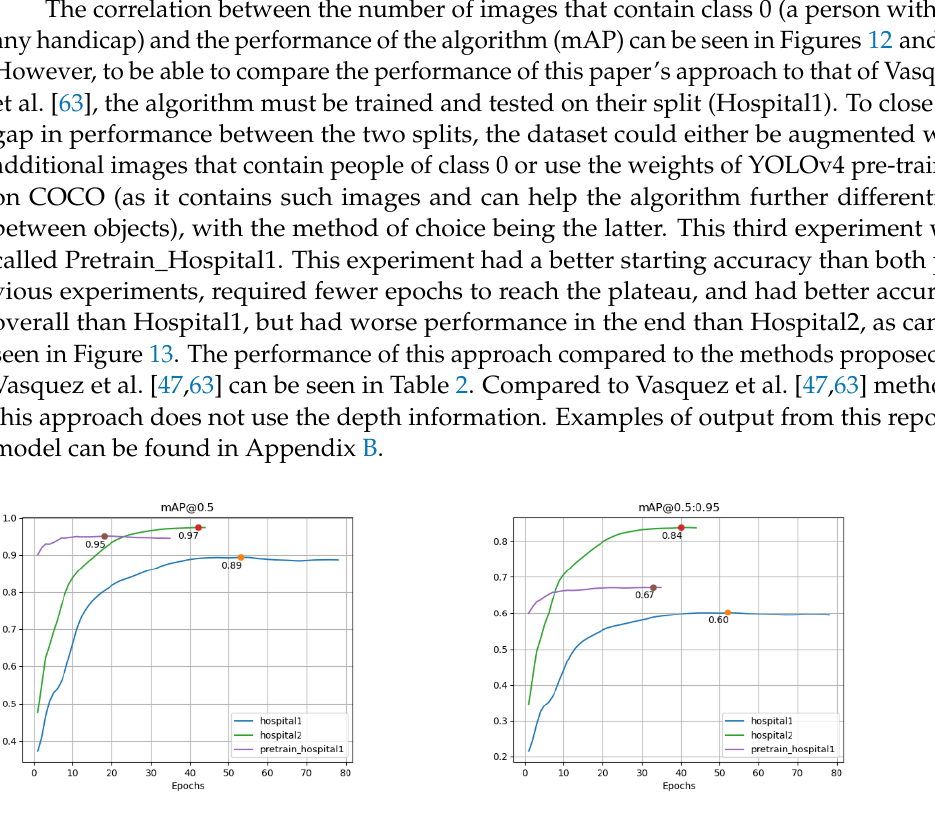
Figure 13. Performance metrics for the Mobility Aids dataset.